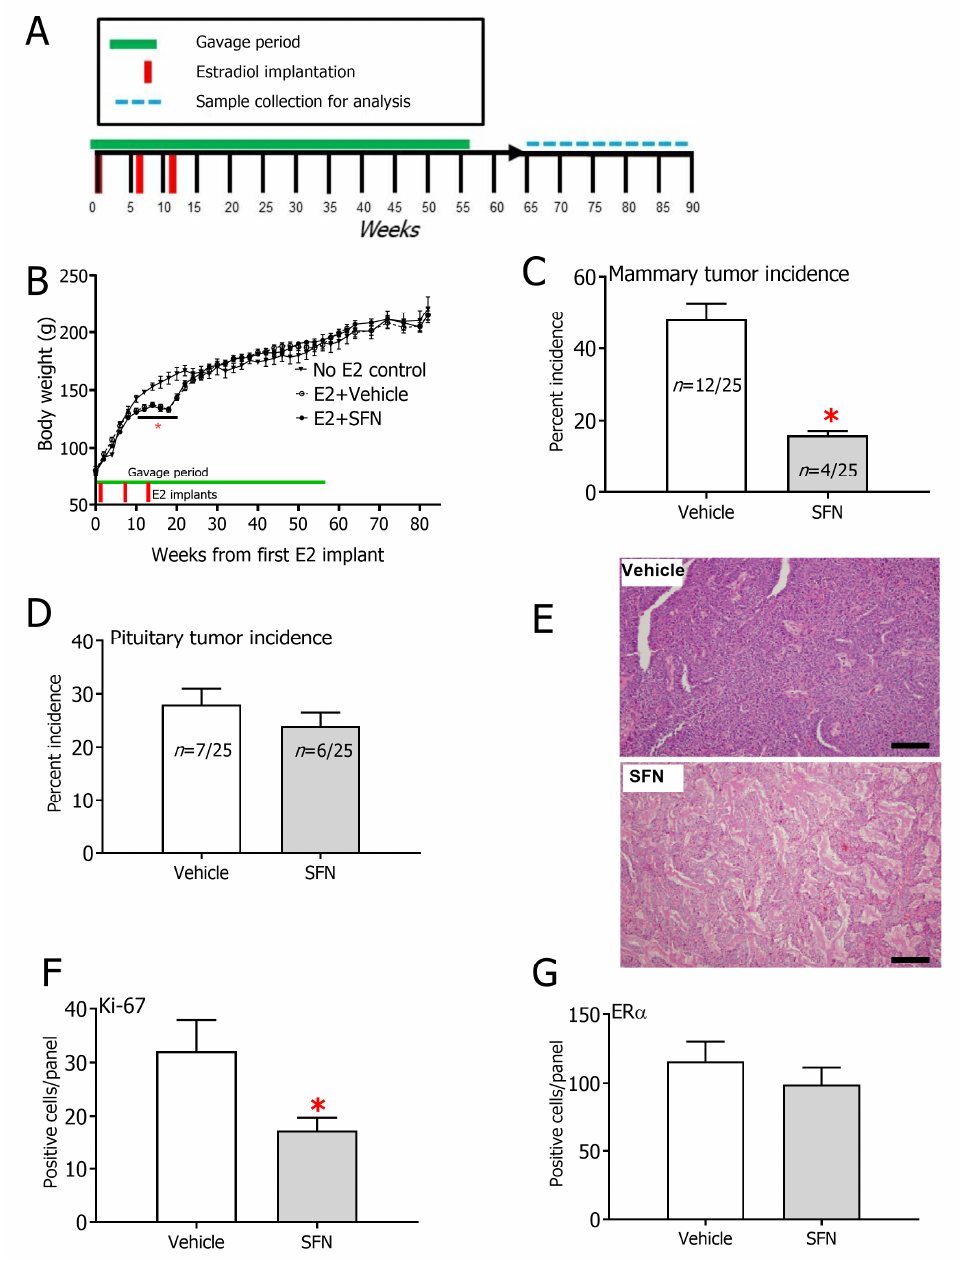
Figure 1. ( A ) Experimental design. ( B ) Trajectories of body weights for rats implanted with E2 pellets that were concurrently gavaged with either vehicle (dimethyl sulfoxide, DMSO) or sulforaphane (SFN). Body weights of age-matched rats that were not implanted or gavaged are also shown ( n = 6). Incidence of ( C ) mammary tumors and ( D ) pituitary tumors in rats exposed to E2. * p < 0.05 (Fisher’s exact test). ( E ) Representative H&E staining images of mammary tumors in vehicle (DMSO) vs. SFN-treated rats. Magnification = 20x, Scale bar = 50 µ m. Quantification of ( F ) Ki-67 ( G ) ER α in mammary tumors. ( n = 3 per group). * p < 0.05 (Student’s t -test).